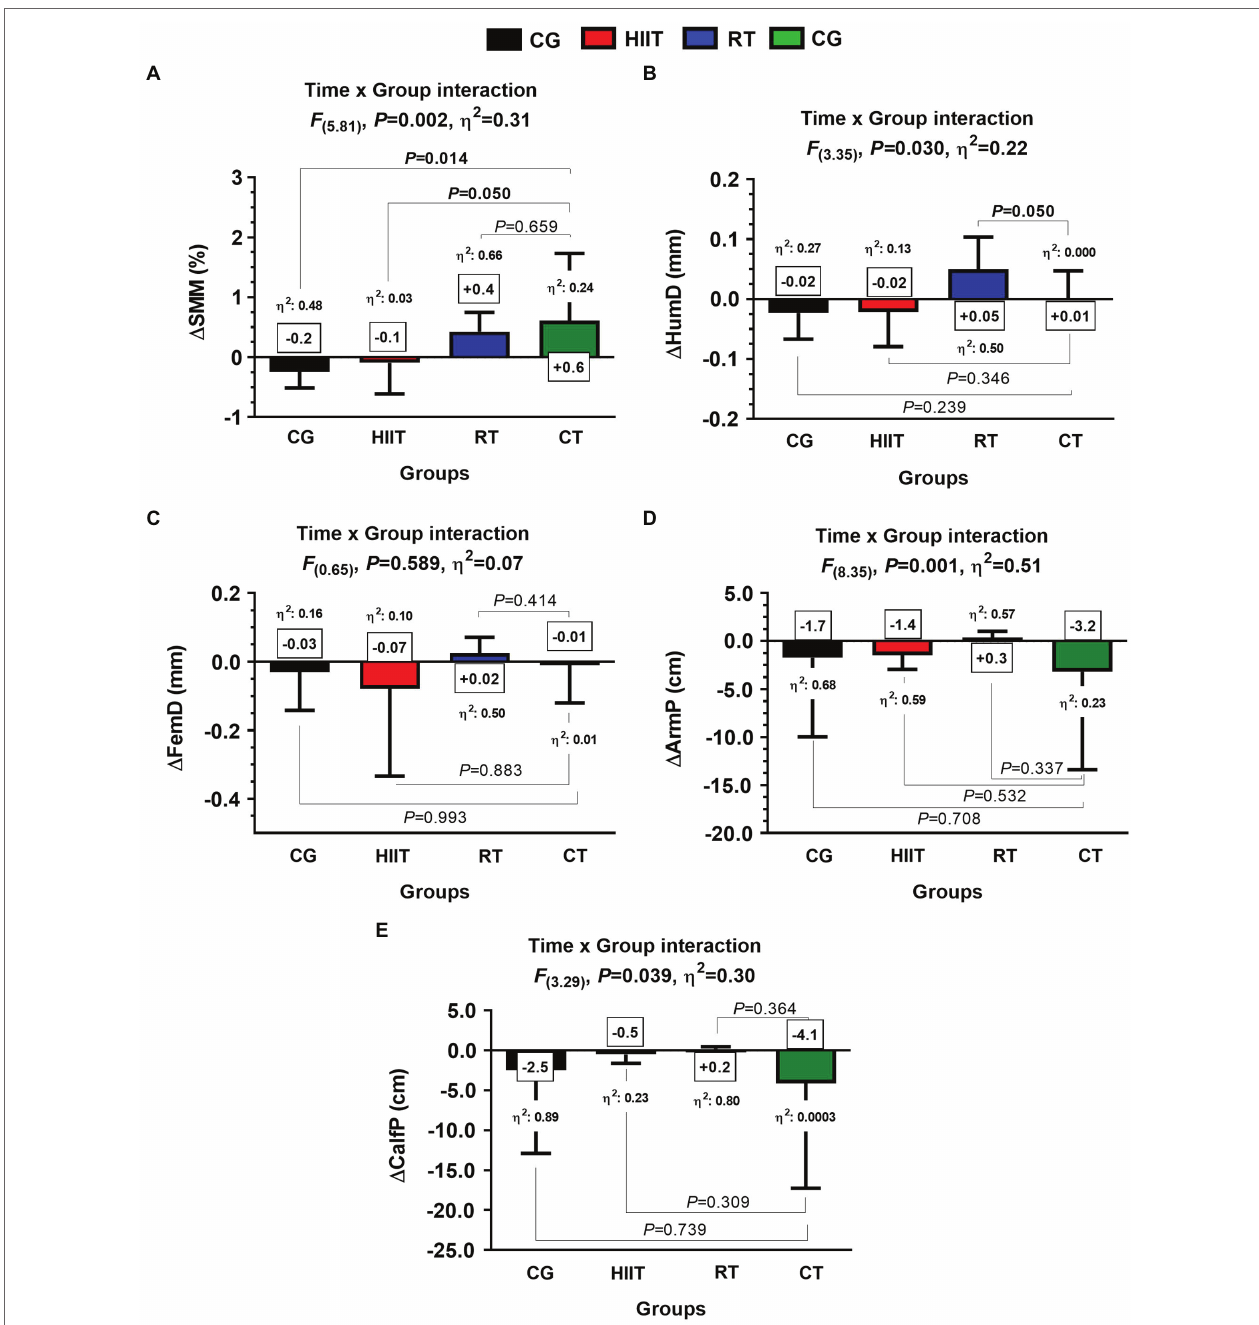
FIGURE 4 | Body composition and anthropometric adaptations in skeletal muscle markers after 12-weeks of three different exercise training programs, or in a control group, in adult women with insulin resistance. Groups are described as: control group (CG), high-intensity interval training (HIIT), resistance training (RT), and concurrent training (CT) group. Outcomes are described as delta skeletal muscle mass ( ∆ SMM) expressed in kg, delta humeral diameter ( ∆ HumD), delta femoral diameter ( ∆ FemD), delta arm perimeter ( ∆ ArmP), and delta calf perimeter( ∆ CalfP). Between-group changes are described in bold values in panels (A,B) . η 2 denotes effect